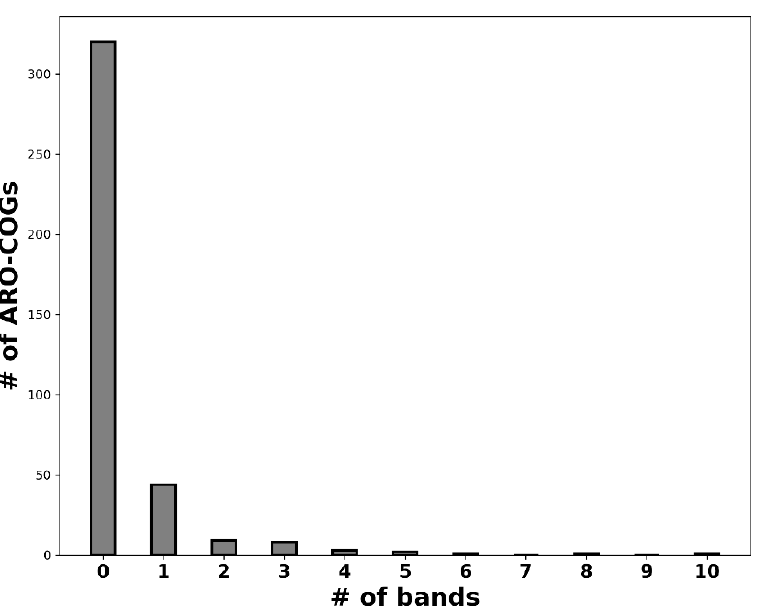
Figure 2. Histogram depicting the distribution of the number of predicted dissemination bands per ARO-COG group.